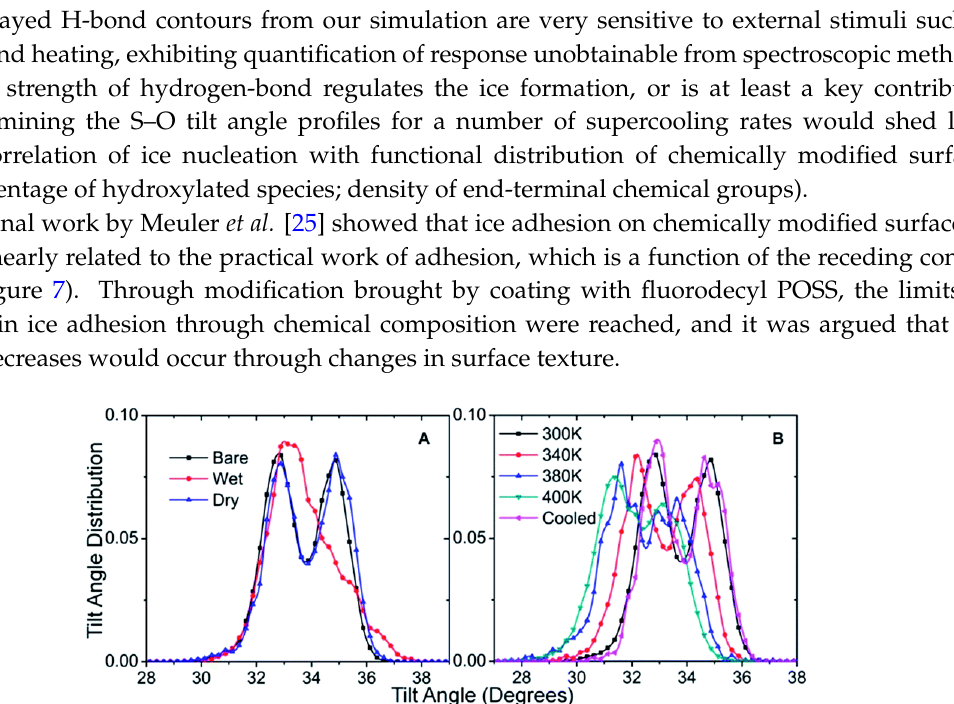
Figure 6. Effect of wetting and high temperature heating on hydrogen bond network of -OH terminated SAM. Reprinted with permission from Ref. [139]. c (cid:13) 2014 Royal Society of Chemistry.